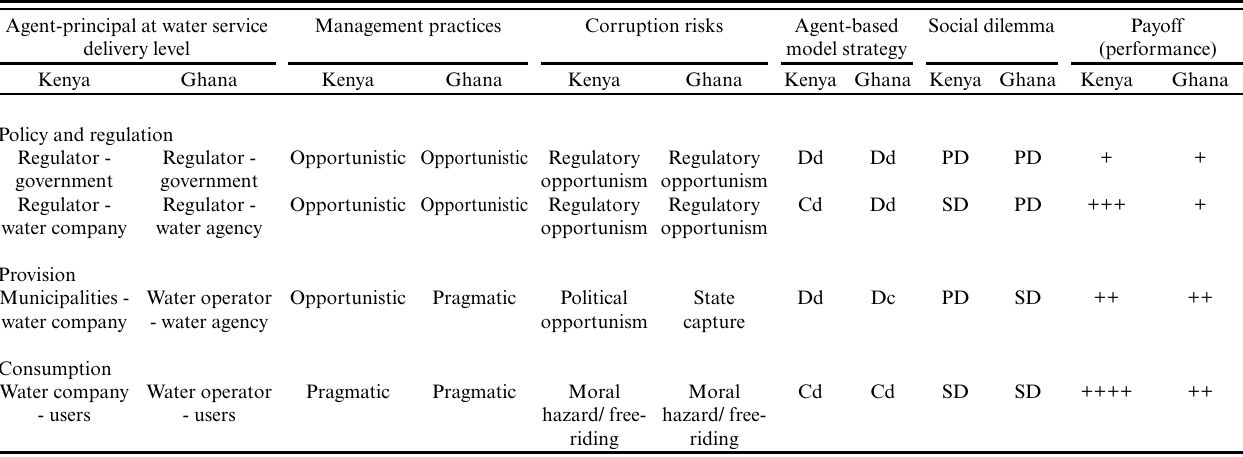
Table 7 . Corruption risks, management practices, resulting strategies, and performance in Kenya and Ghana.